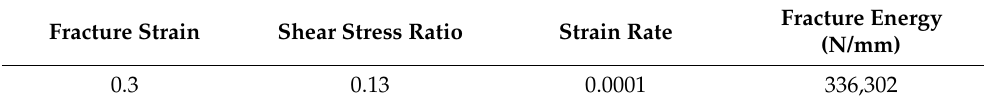
Table 5. Shear damage and fracture properties of steel.